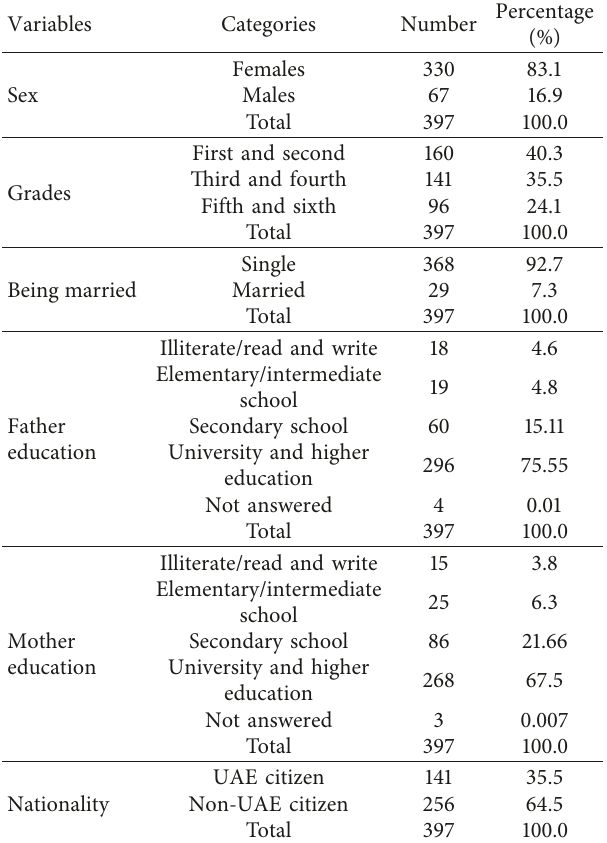
Table 1: Sociodemographic characteristics of the study participants ( n � 397).